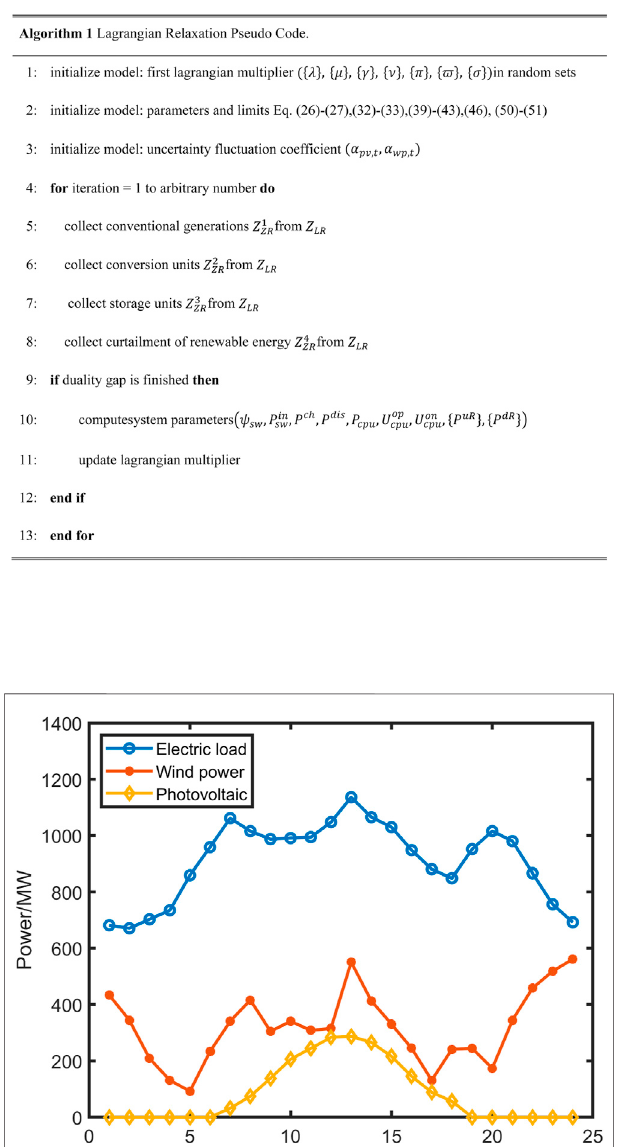
TABLE 1 | The Parameters of The Multi-Energy Conversion and Storage Units. Equipment